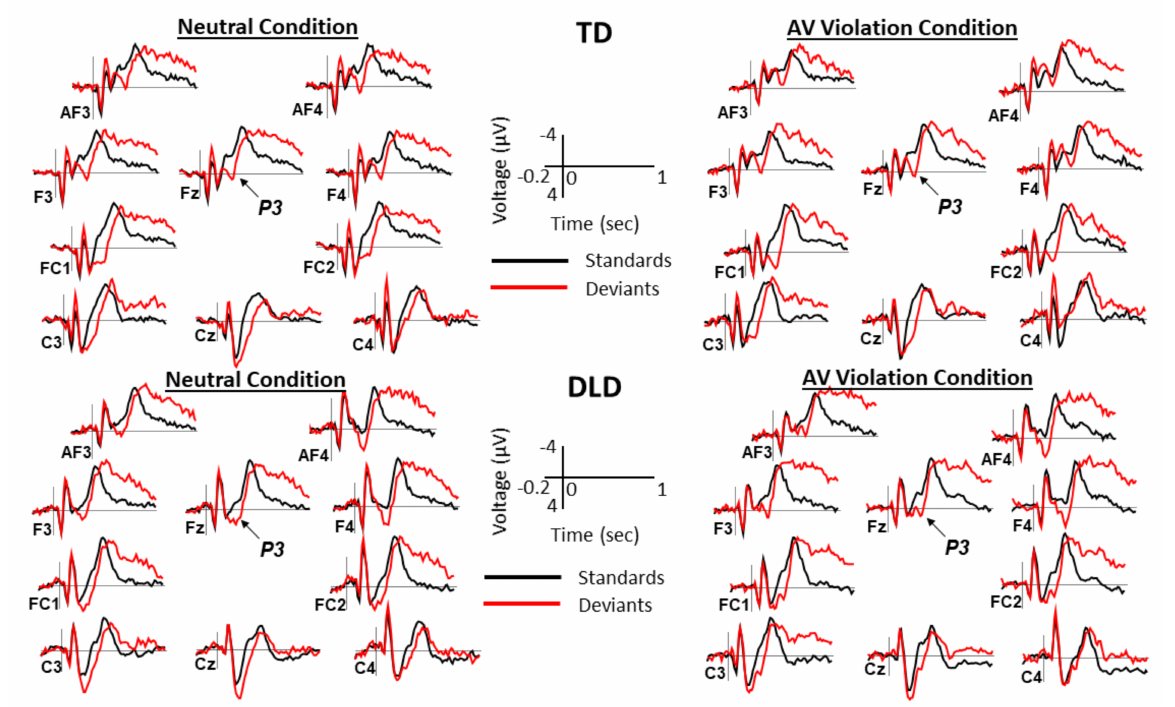
Figure 3. ERPs elicited by standards and deviants over the anterior scalp. Grand average ERPs over the 12 anterior sites are shown separately for children with TD and those with DLD. In each condition, grand averages for standards (black lines) are overlapped with grand averages for deviants (red lines). Negative is plotted up. The P3 component is marked on the Fz site. Time 0 marks the onset of sound. AV = audiovisual.